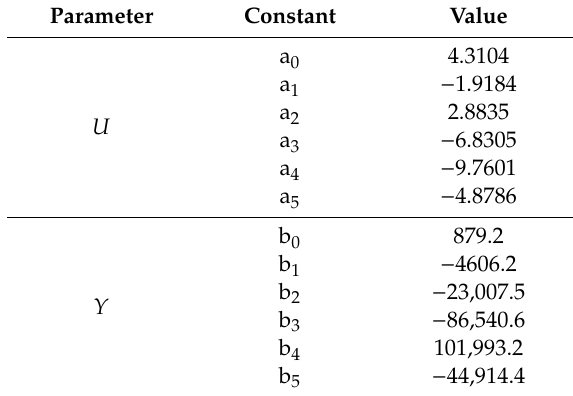
Table 2. The fitting parameters used in the Newman, Tiedemann, Gu, and Kim (NTGK) model. Parameter Constant